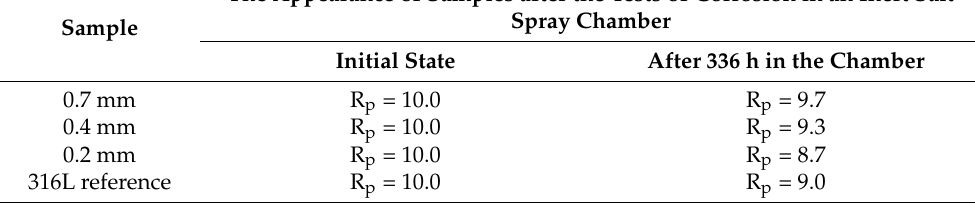
Table 5. The results for corrosion resistance after testing in the salt